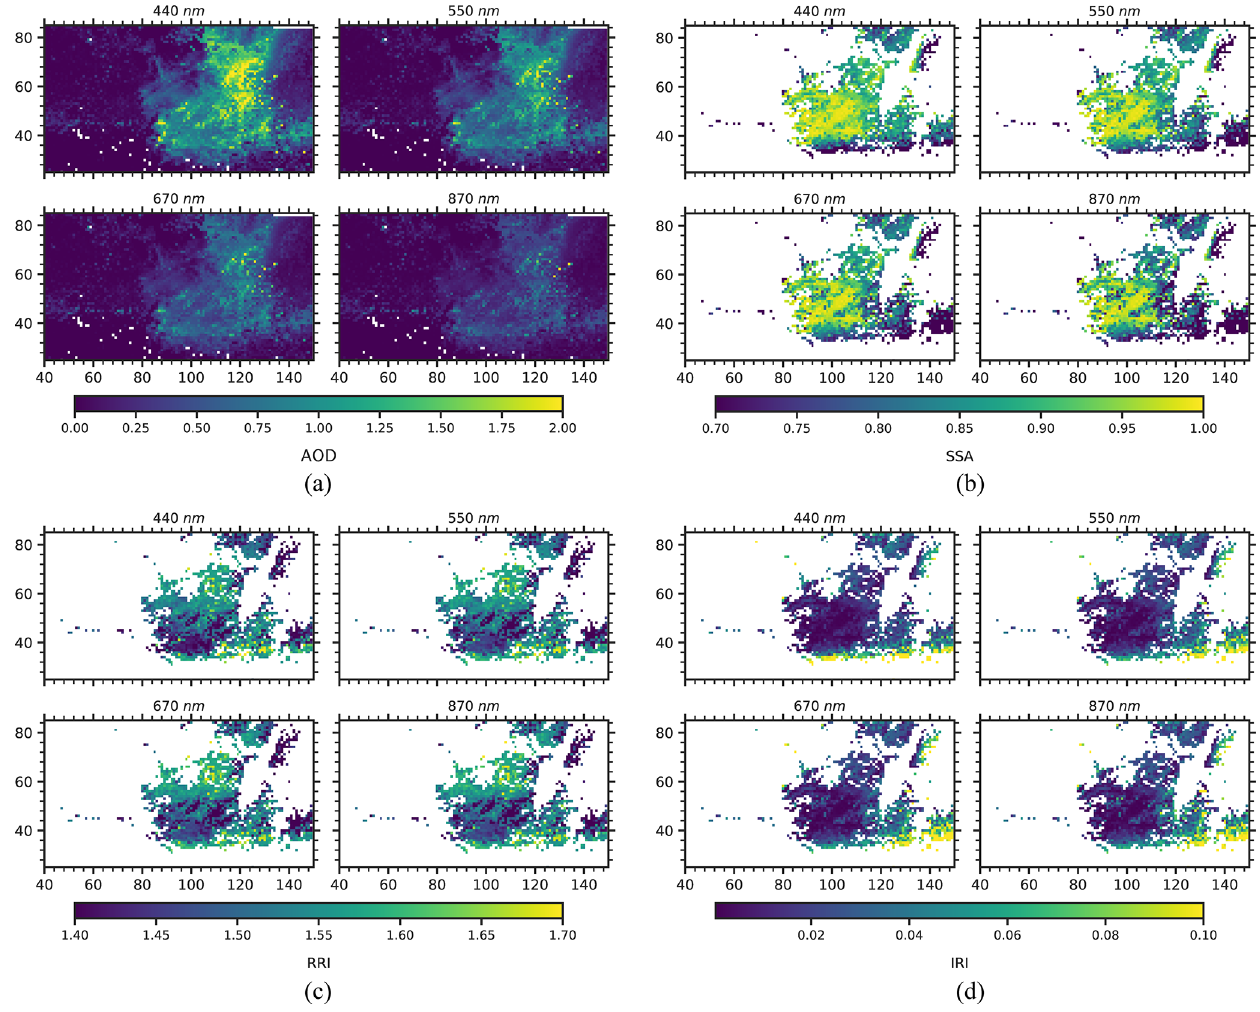
Figure 9. (a) AOD map of a subsetted portion of the 27 October 2017 T18:16UTC smoke scene that was marked by a red rectangular box in Fig. 8; (b) single scattering albedo (SSA) for the same subsetted portion in (a) , but the pixels with the goodness of fit, χ 2 norm > 5 and AOD 440nm < 0 . 4 are masked. (c) Same as (b) except the real part of the refractive index (RRI) is plotted. (d) Same as (b) except the imaginary part of the refractive index (IRI) is plotted. X and Y axes are the pixel